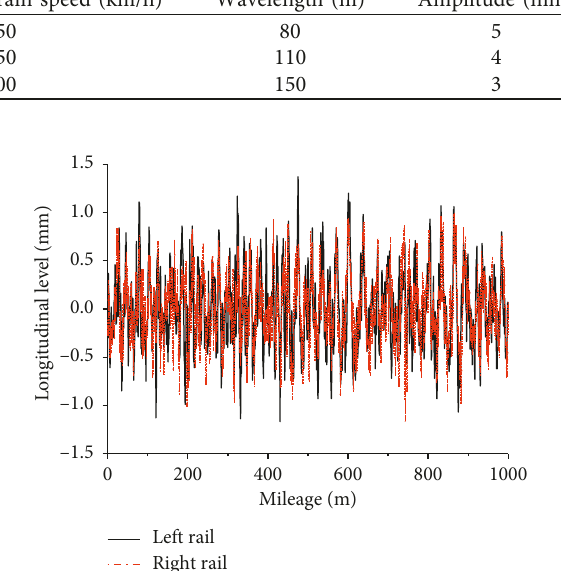
Figure 14: Measured track longitudinal-level irregularities.